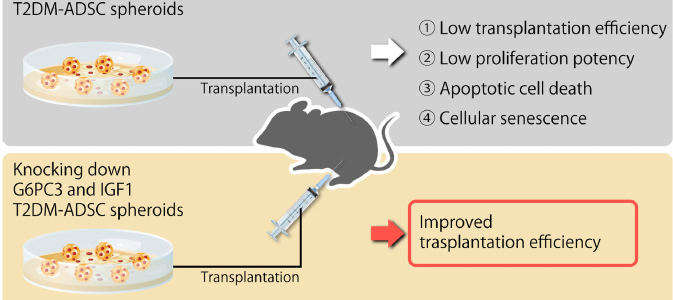
Figure 6. Summary diagram of this